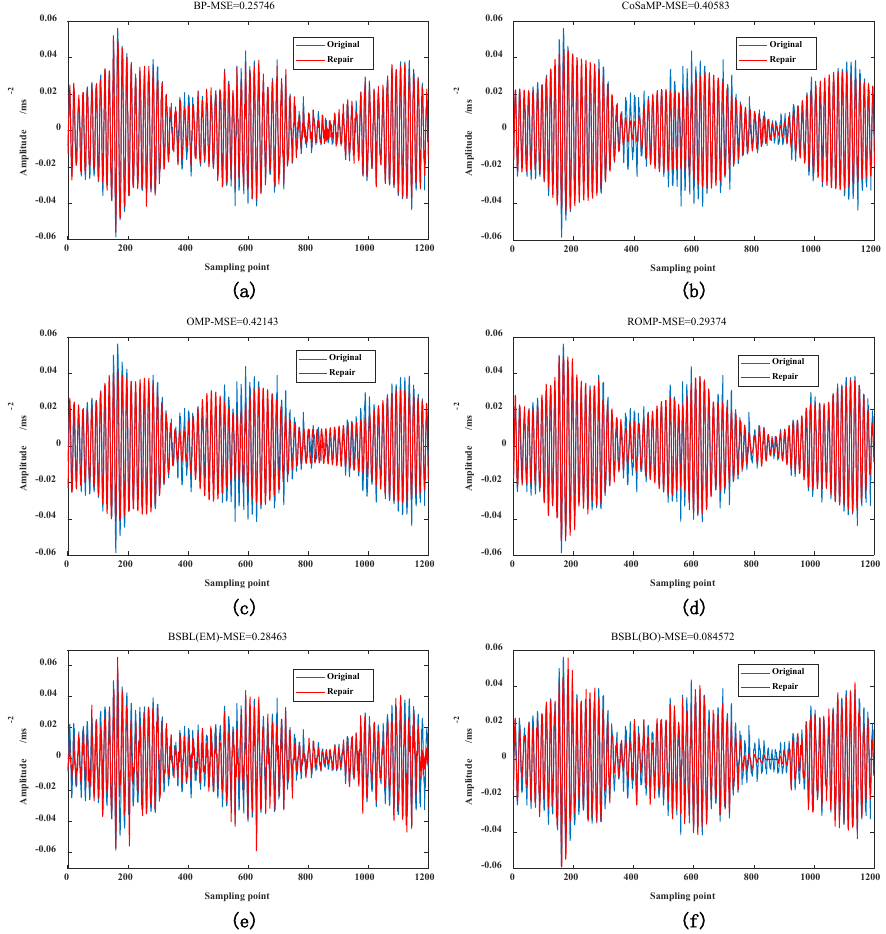
Figure 4. Valve_1200_7mm dataset: ( a ) BP algorithm (MSE = 0.25746); ( b ) CoSaMP algorithm (MSE = 0.40583); ( c ) OMP algorithm (MSE = 0.42143); ( d ) ROMP algorithm (MSE = 0.29374); ( e ) BSBL(EM) algorithm (MSE = 0.28463); and ( f ) BSBL(BO) algorithm (MSE =